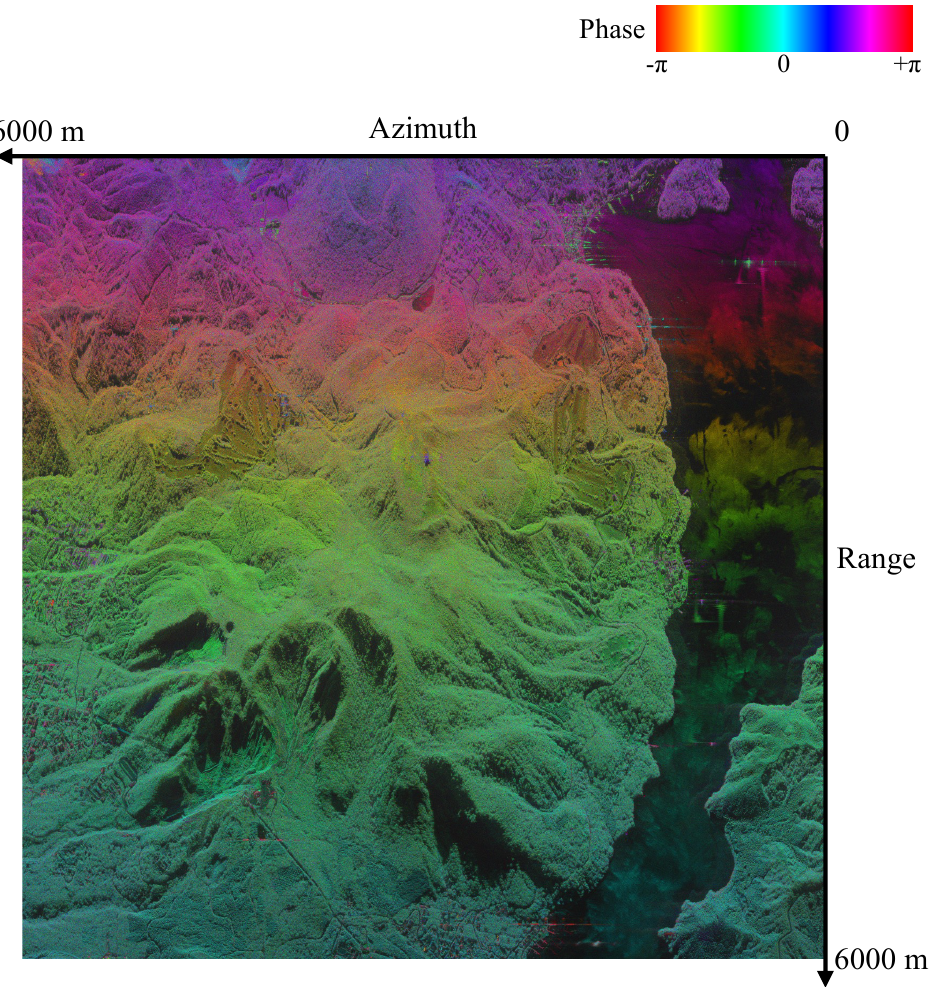
Figure 4. MGP_H_VVm image around Mount Hakone on 3 December 2015 (Center: N35.218,